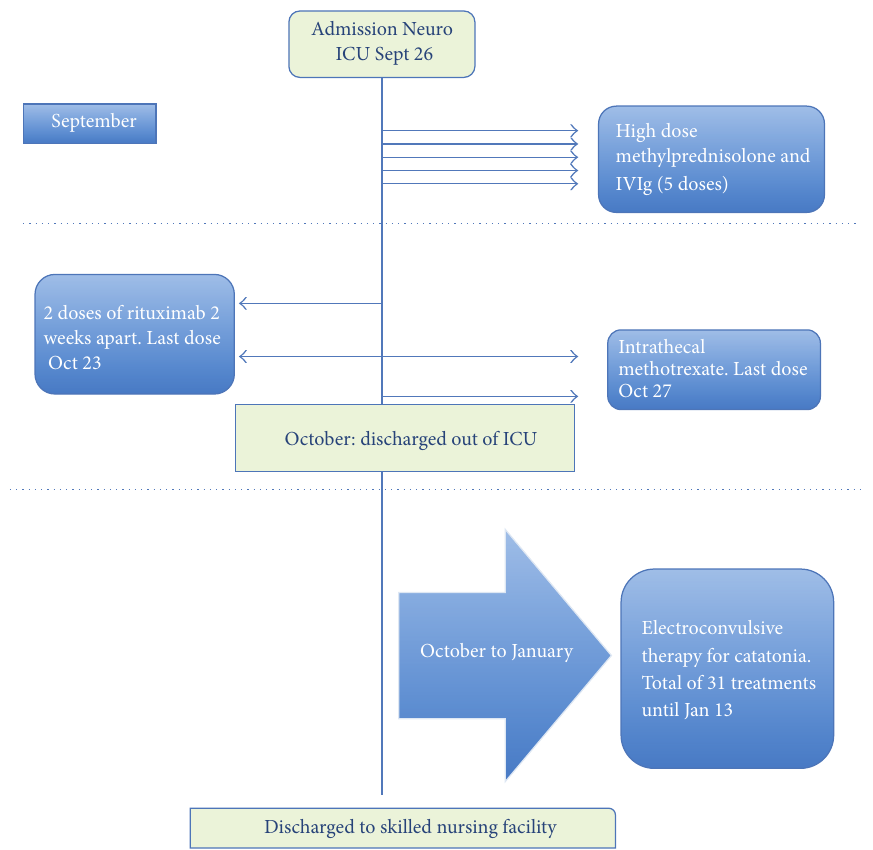
Figure 4: A brief snapshot of therapies and management strategies during